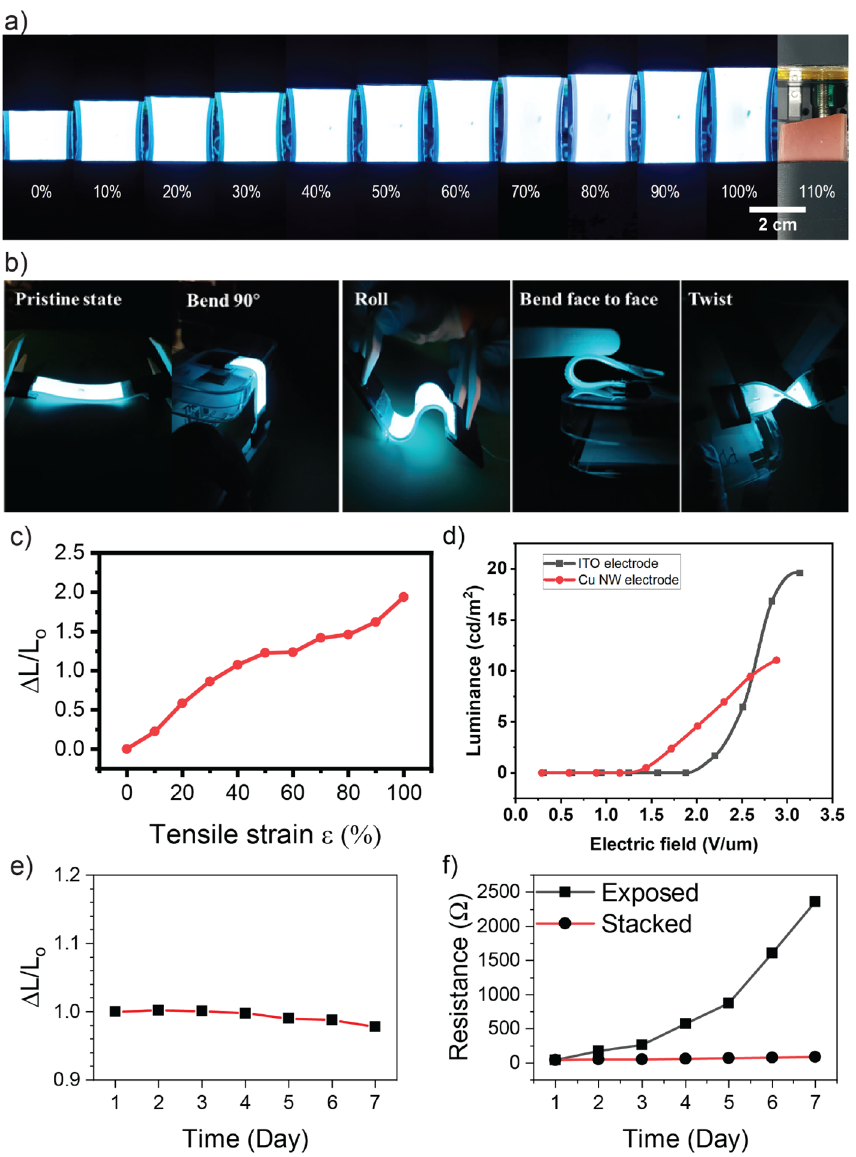
Figure 7. ( a ) Photographs of a light-emitting device under various strain values. ( b ) Snapshot of the light- emitting device under different deformations. ( c ) Luminance changes with the strain applied up to 100%. ( d ) Luminance of Cu NW-based electrode EL device compared to ITO-based electrode EL device. ( e ) Luminance changes of the EL device placed in room temperature, ambient conditions for 7 days. ( f ) The resistance changes of Cu NW electrode exposed directly in the air and Cu NW electrode stacked in the EL device for 7